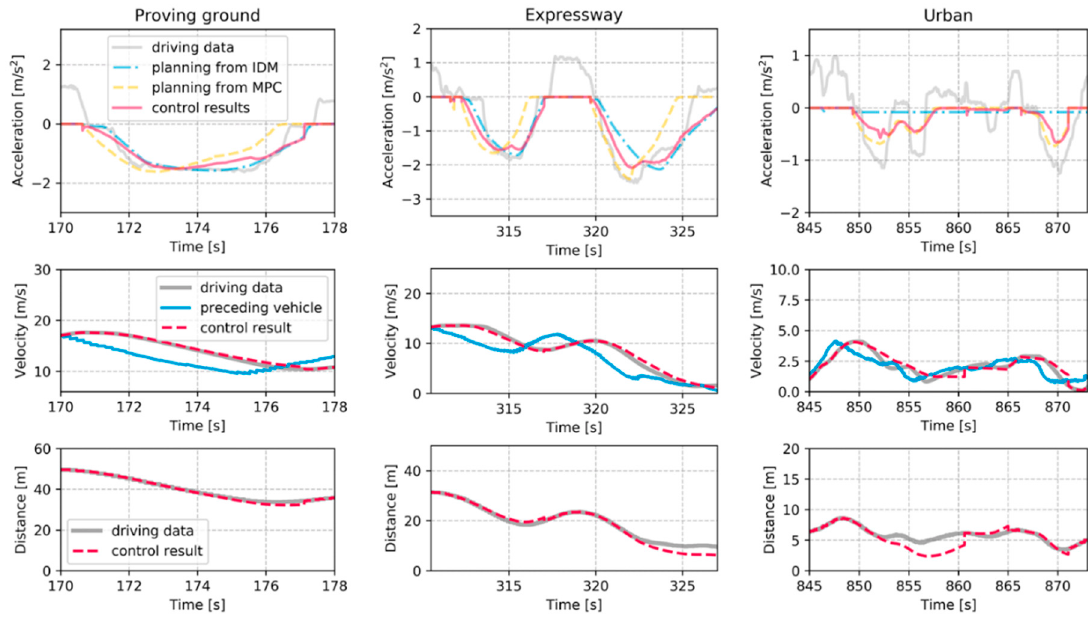
Figure 18. Validation results under various deceleration cases.